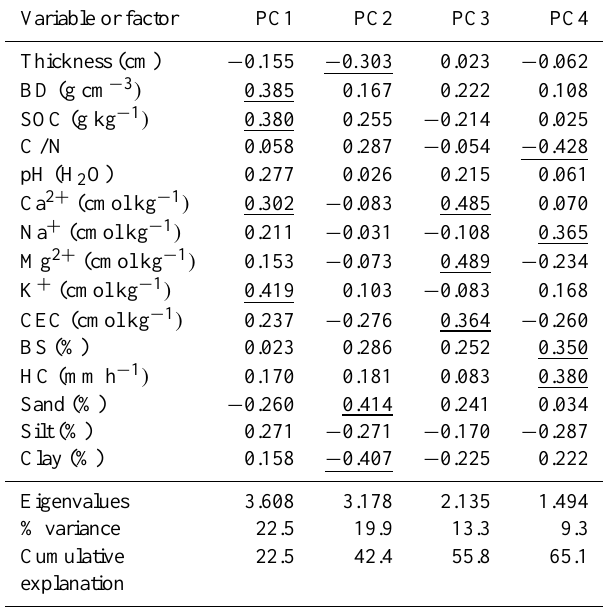
Table 5. Ordinary components for the principal component analysis (PCA) of selected soil properties measured for all the soil types grouped ∗